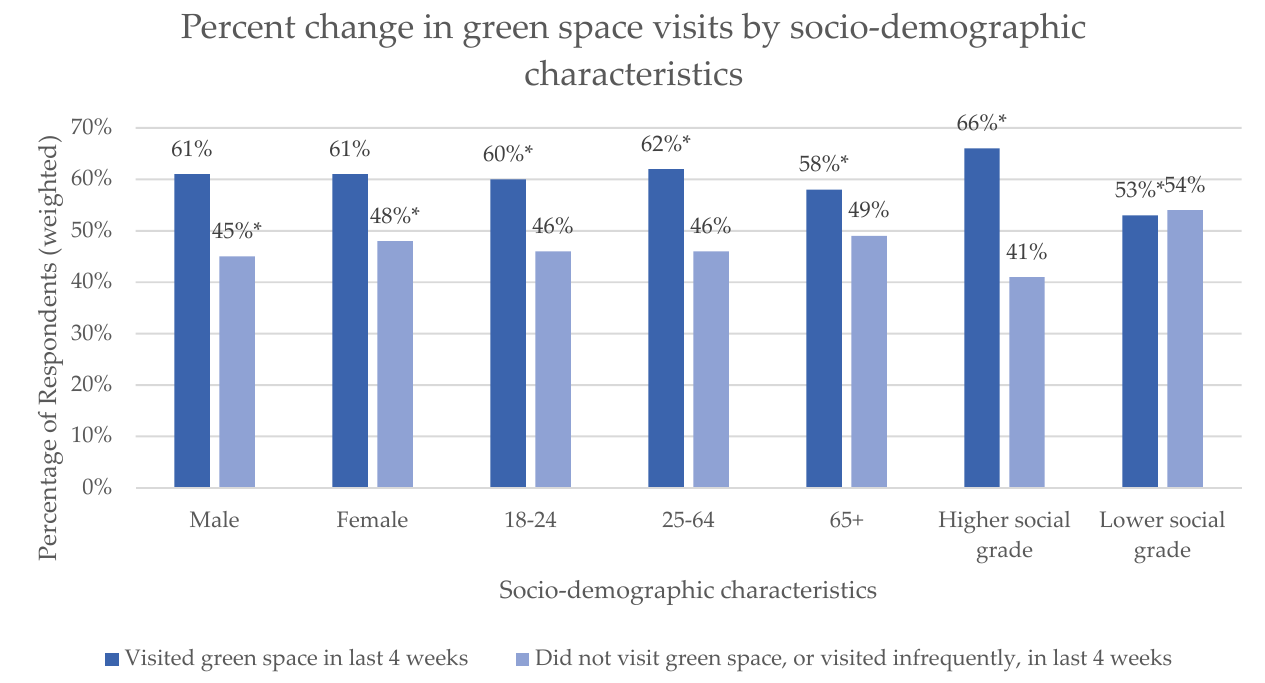
After adjustment for socio-demographic characteristics, the odds of respondents reporting visiting green spaces were significantly higher in wave 2 (OR: 1.28 (95% CI: 1.15– 1.44)) than in wave 1 (Table 3). By wave 3, they were significantly higher than both waves 1 and 2 (OR: 2.25 (95% CI: 1.99–2.55)). Table 3. Odds ratios (95% CI) from logistic regression models predicting either visiting green space or reported barriers to visiting. Visited Green Space in Previous 4 Weeks